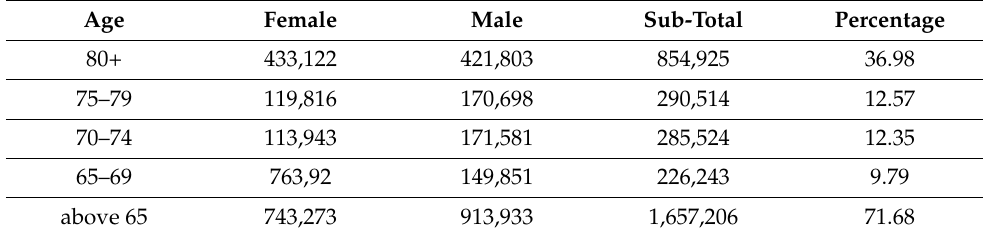
Table 1. Age and gender distribution of world COVID-19 deaths (n =